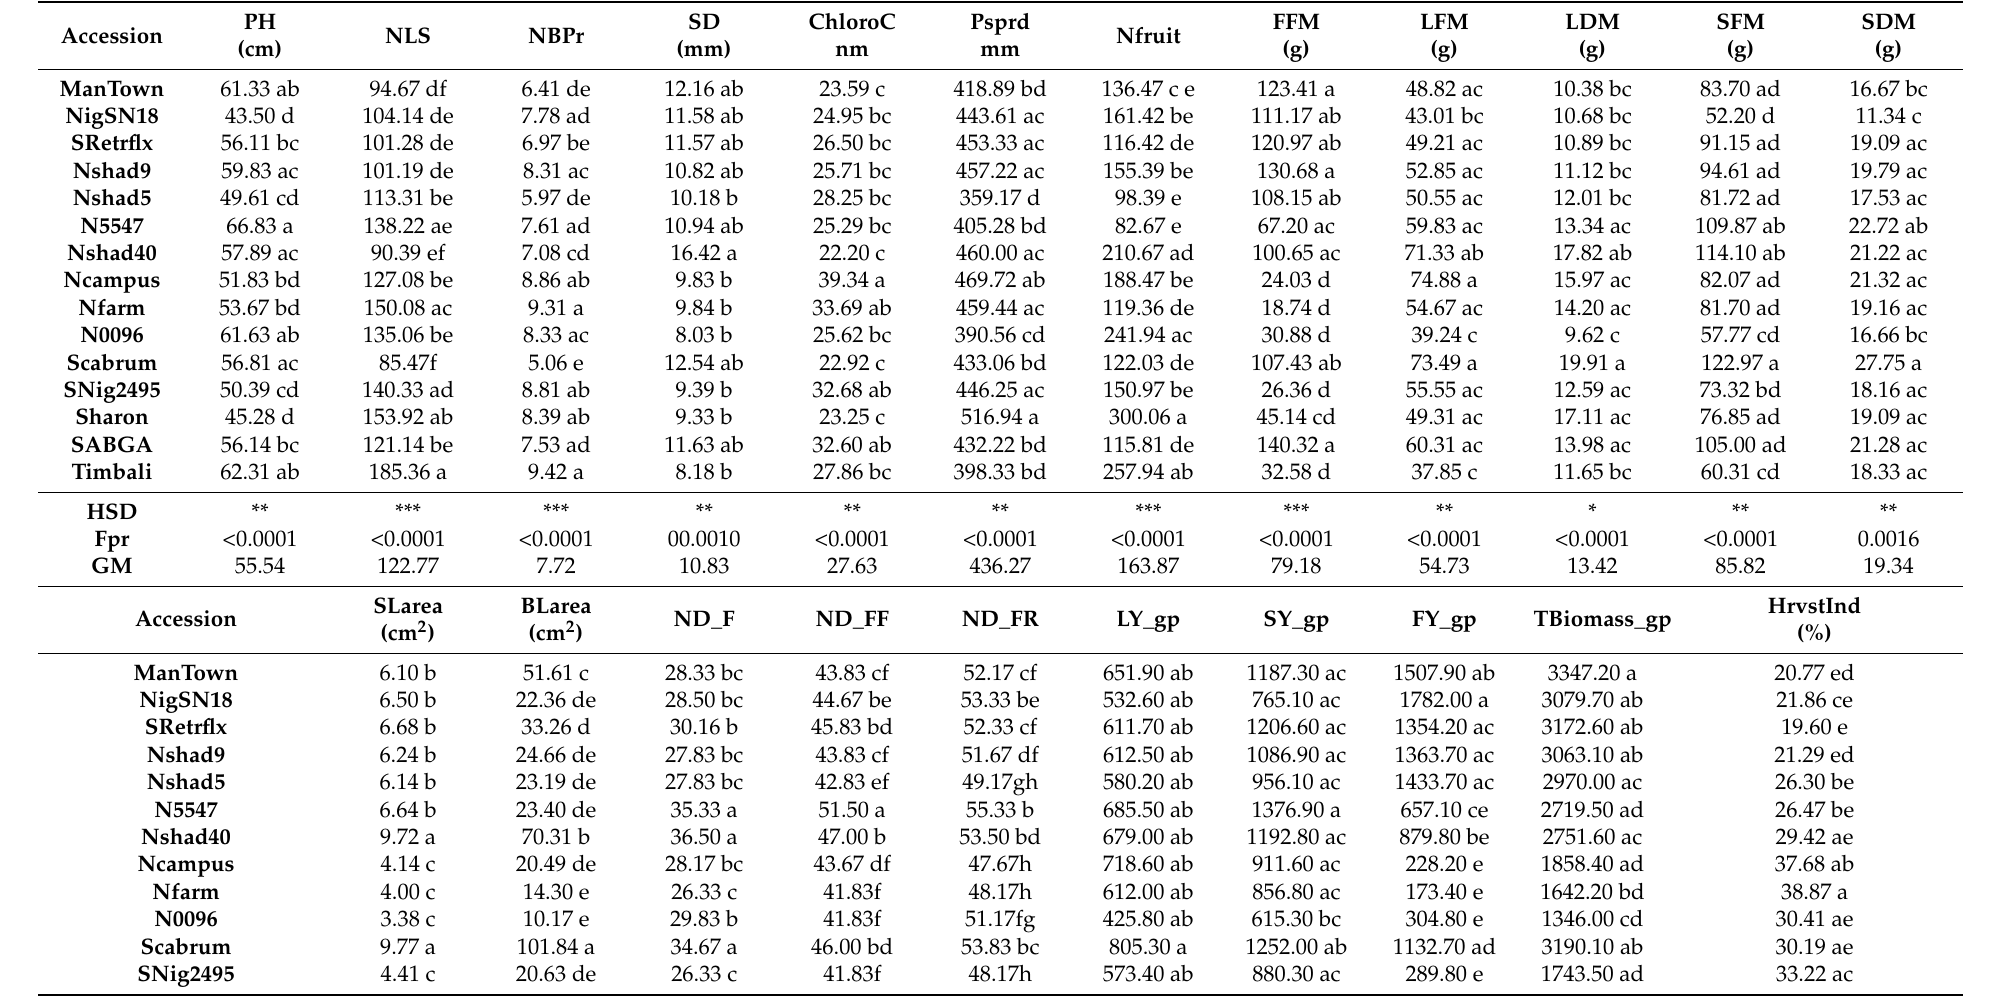
Table 2. Variation for 22 traits in 15 nightshade accessions and means under combined